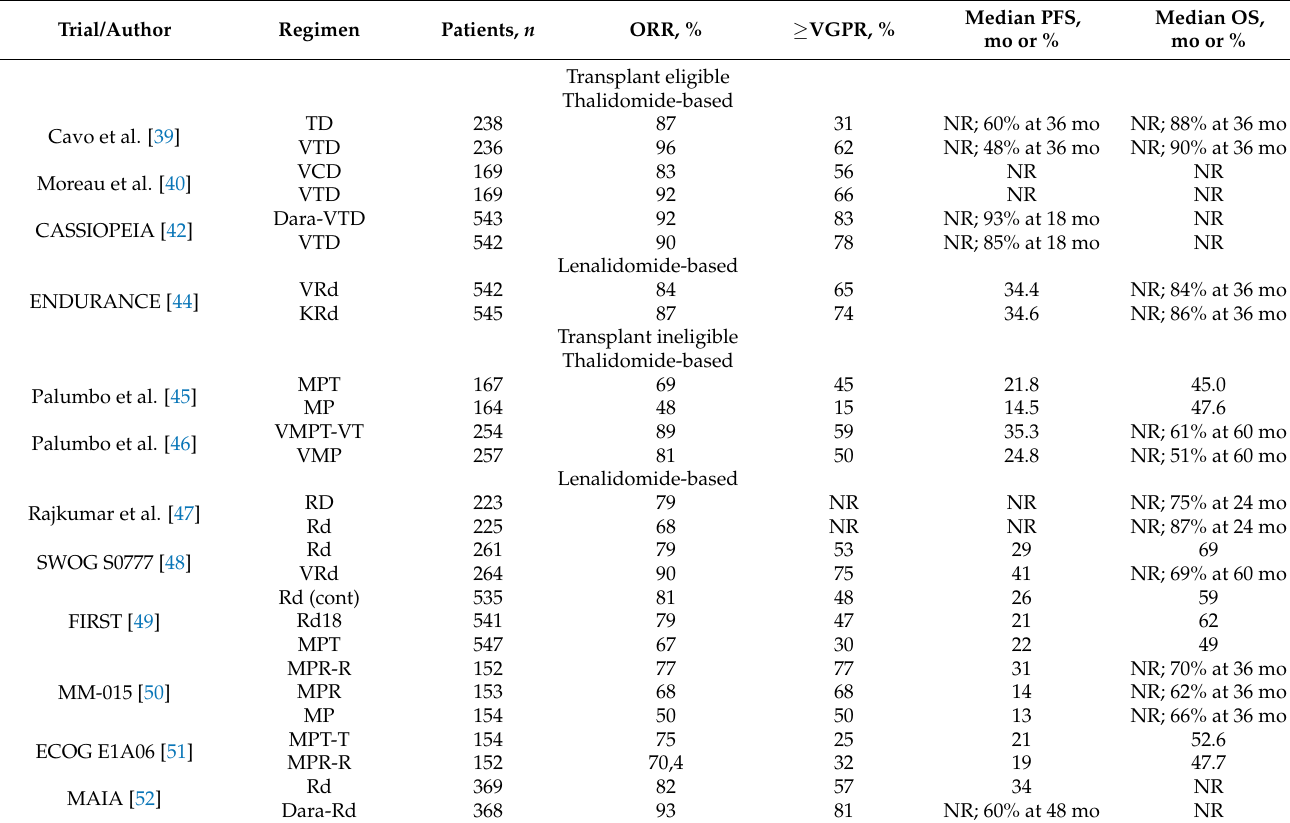
Table 1. Results of randomized studies in newly diagnosed multiple